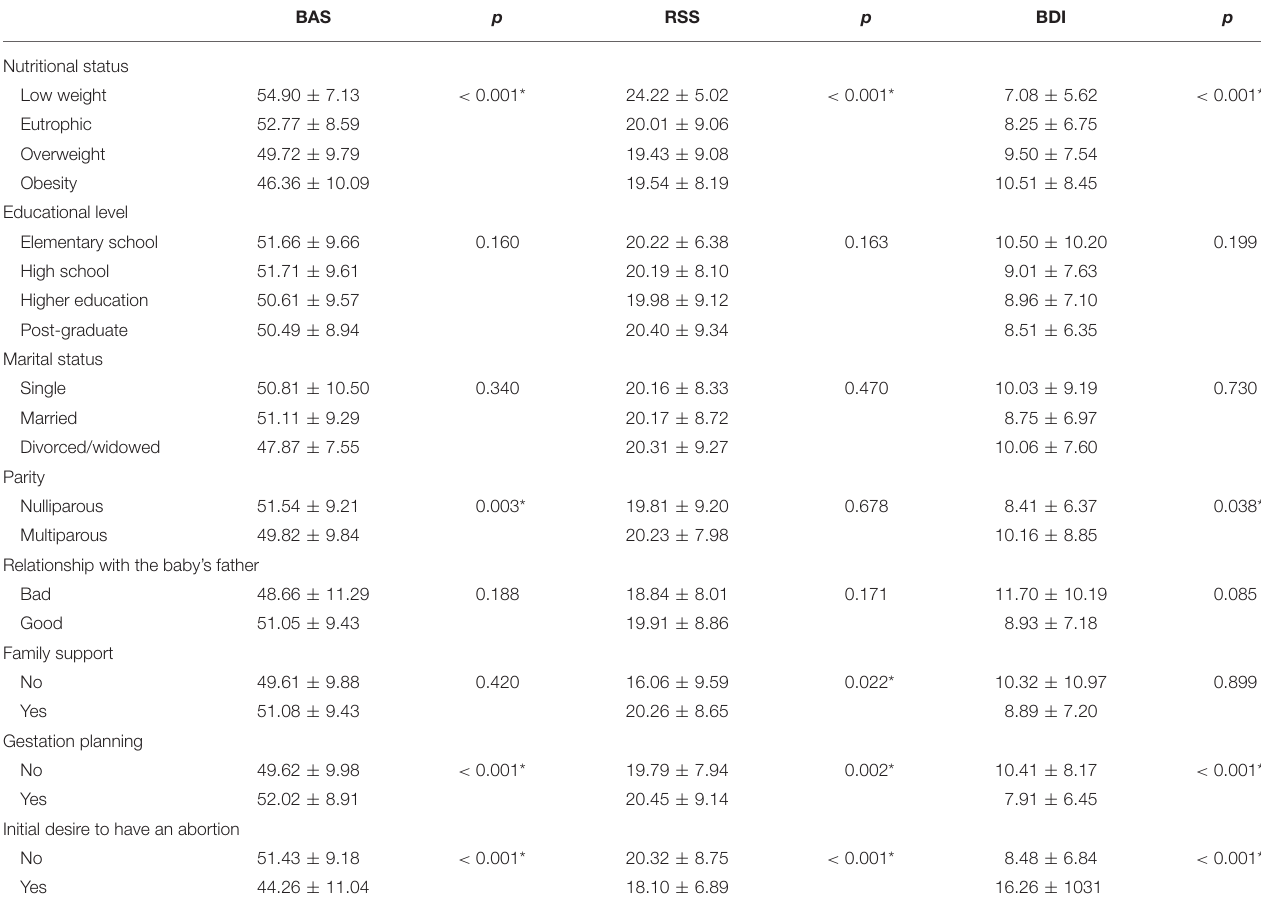
TABLE 2 | Preliminary analysis of differences in the outcomes based on demographic variables. BAS p RSS p BDI